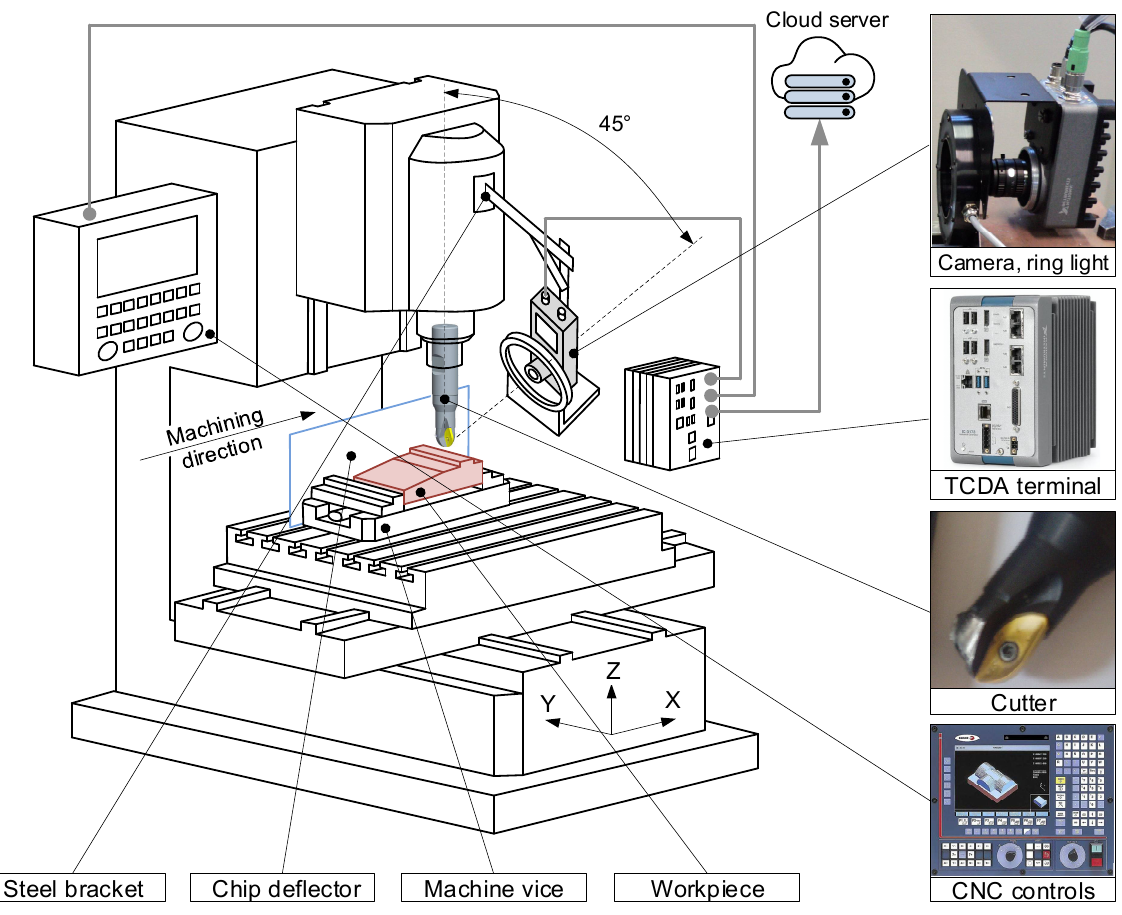
Figure 5. Experimental setup (schematic view).